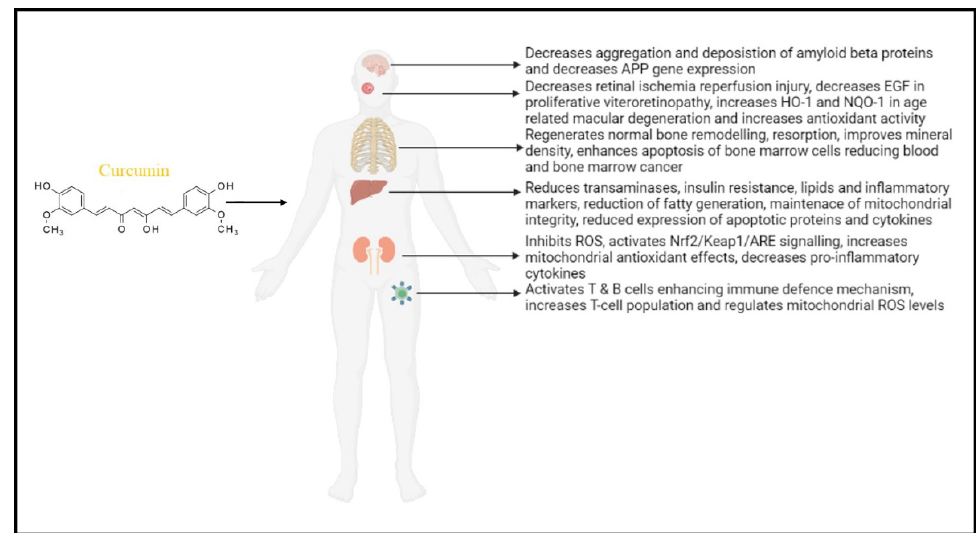
Figure 2. Role of curcumin in reducing mitochondrial dysfunction in various organs: in the brain— Alzheimer’s disease; eye—retinal infection; skeletal system; liver function; kidney disease, and lymphocyte regulation. Curcumin mainly regulates ROS levels and maintains the antioxidant system for proper regulation of mitochondrial function. (APP—amyloid precursor protein; EGF—epidermal growth factor; HO-1—Heme oxygenase 1; NQO1—NAD(P)H quinone oxidoreductase 1; Nrf2—nuclear factor erythroid 2-related factor 2; Keap1—Kelch-like ECH-associated protein 1; ARE—antioxidant response